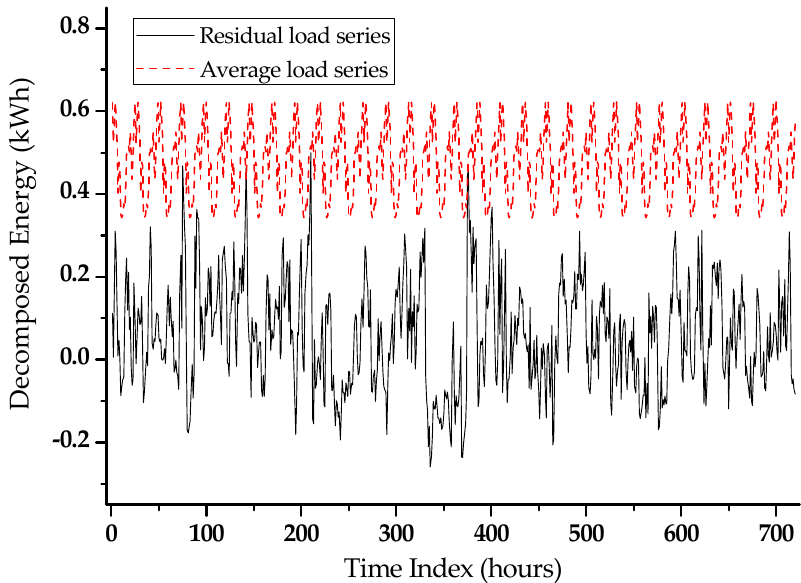
Figure 3. Average and its residual load series of a single household.